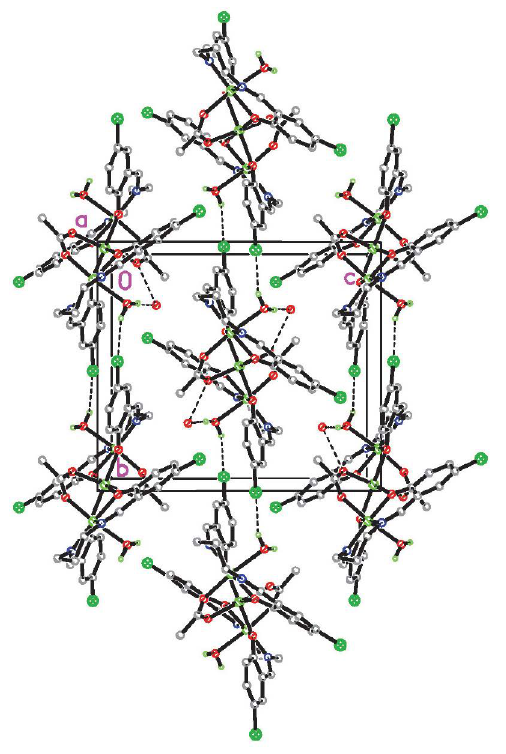
Fig. 2. Molecular packing diagram of the complex, viewed along the a axis. Hydrogen bonds are drawn as dashed